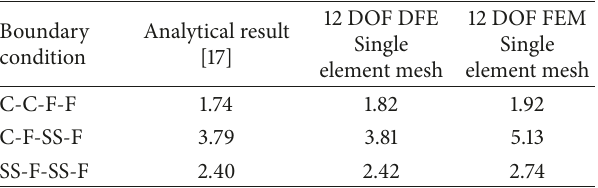
Table 2: Comparison between DFE and FEM formulations against analytical solution values of 𝜔√𝜌𝑡/𝐷 for fundamental natural frequency under different boundary